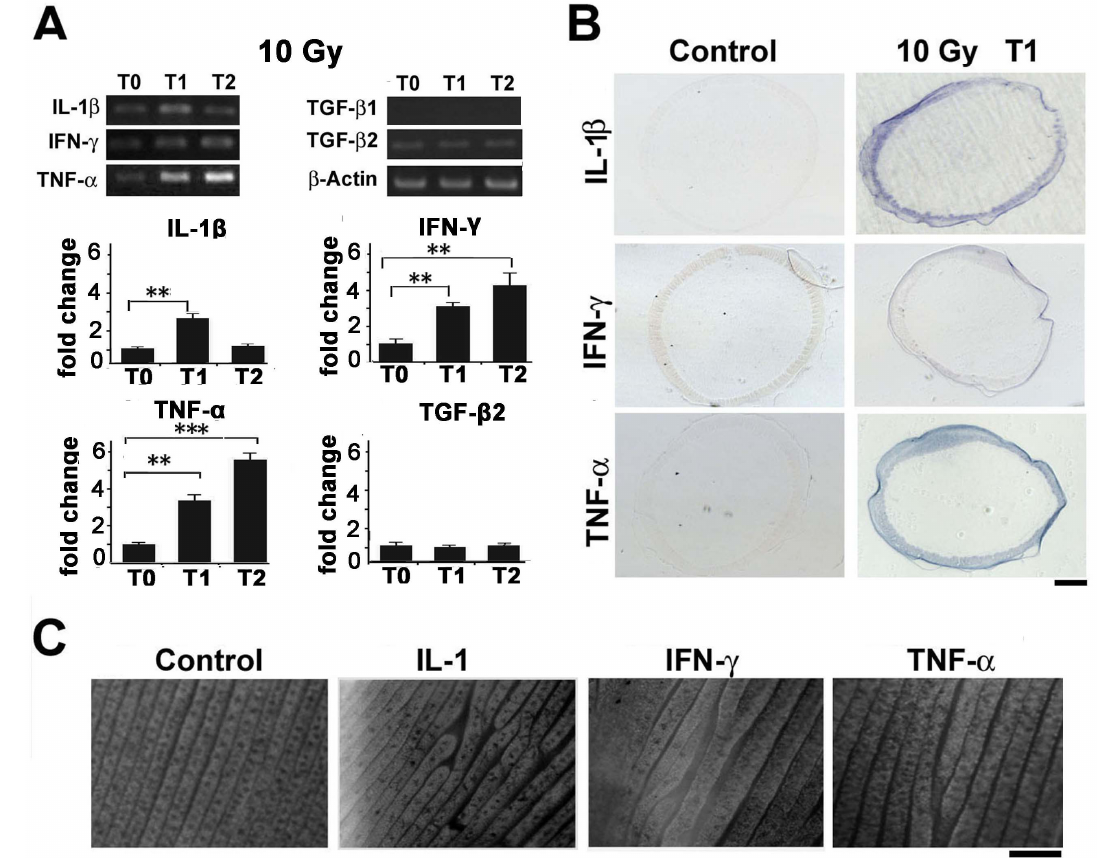
Figure 4. Cytokine gene expression and manipulation in the feather follicles. (A) RT-PCR analysis showing increased expression of IL-1beta, IFN-gama, TNF-alpha, but not TGF-beta1 or TGF-beta2 in the feather follicles. Densitometry of the results were quantified and statistically analyzed. **, p , 0.01; ***, p , 0.001. (B) In situ hybridization showing cytokine genes are induced mostly in the epithelium at T1 samples (1 day post-IR). (C) Whole- mount view of feather epithelial branching after protein delivery into the feather follicles in vivo. Samples were collected 2 days post-treatment. In control experiments, BSA protein was used. Representative data from at least three experiments were shown. Bar=100 m m.